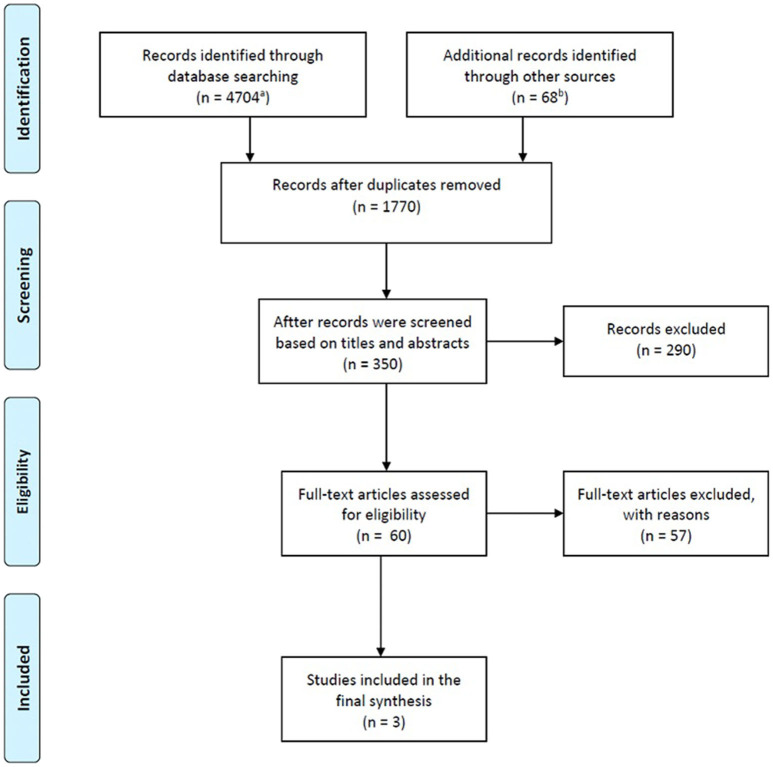
Flowchart of the literature search process. aSee Table 3 for details. bIncluded those identified from the references and those identified through screening the first 100 hits of the various word combinations.